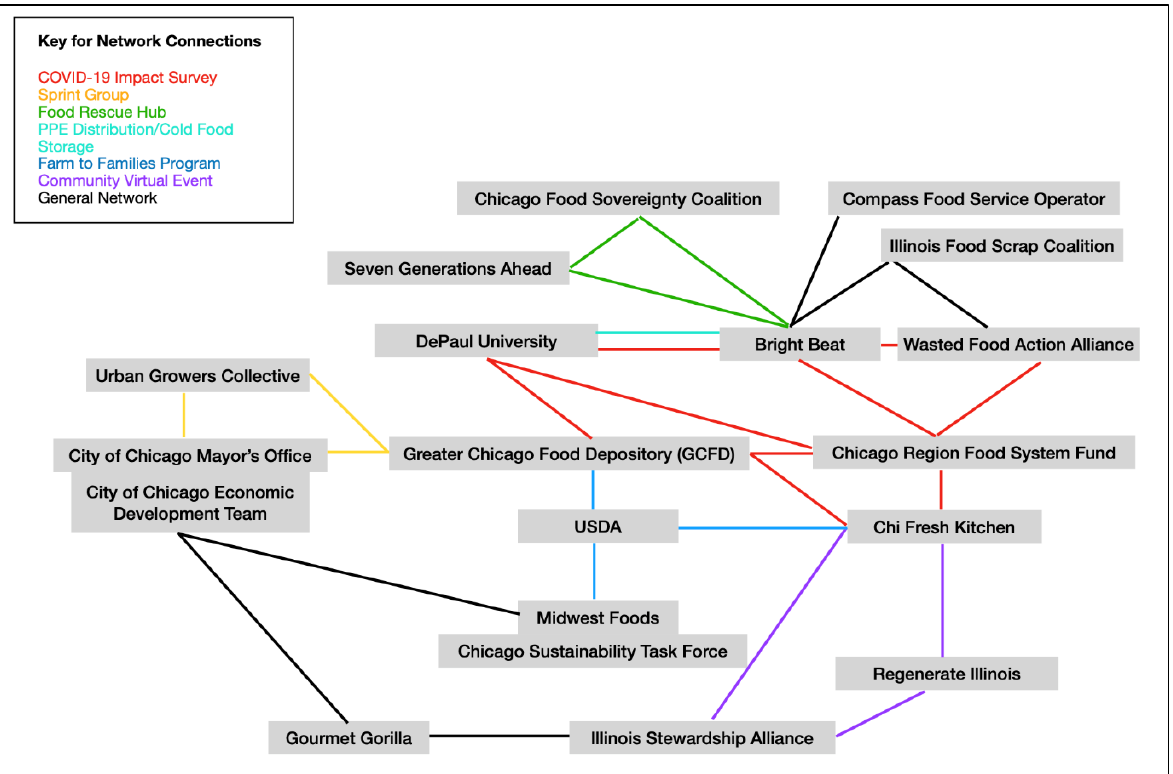
Figure 1. Nonstaff Call Participants Described Strengthening or Forming New Network Connections with Other Organizations through the Rapid Response